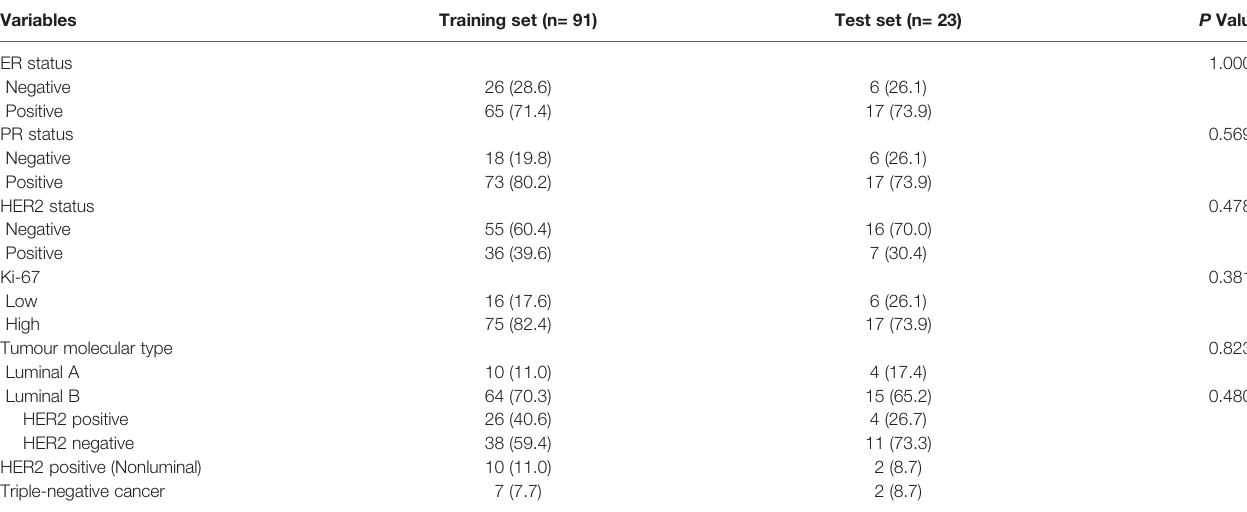
TABLE 3 | Clinical characteristics of the breast cancer patients in the training and test